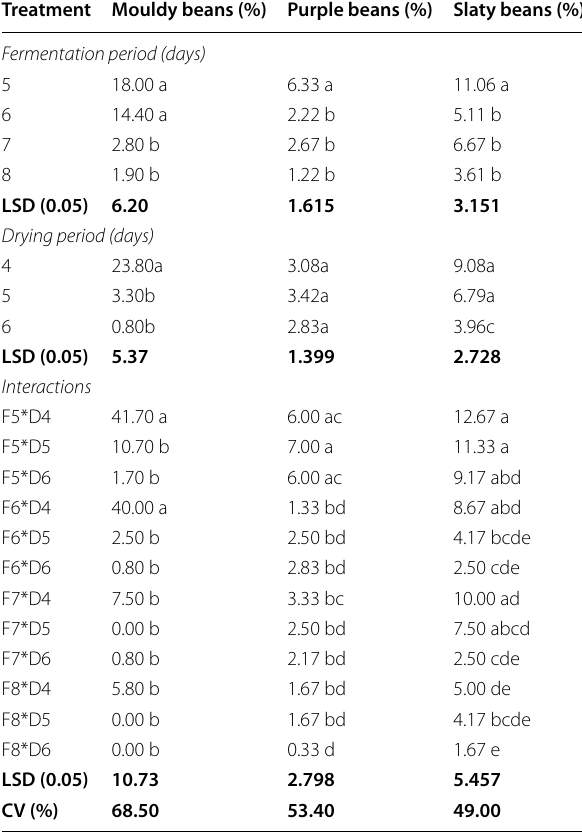
Bolding was done to differentiate the treatment means from the rest of the content of the table LSD, Least Significant Difference; CV, Coefficient of Variation Within column means with different letters differ significantly ( p